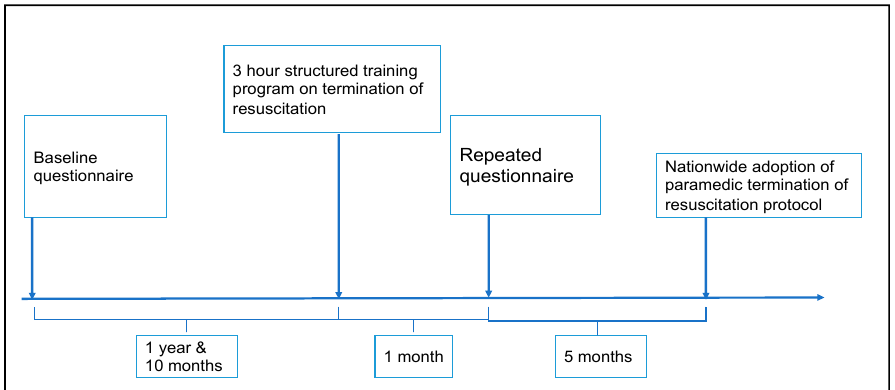
Figure 2. Chronology of events. Figure is not drawn to scale.